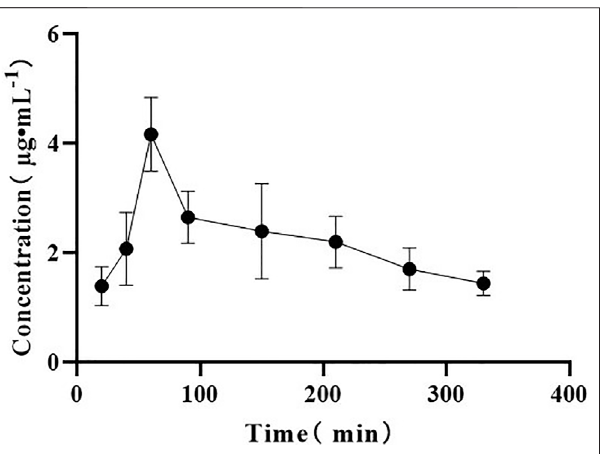
FIGURE 5 | Drug-time curve of